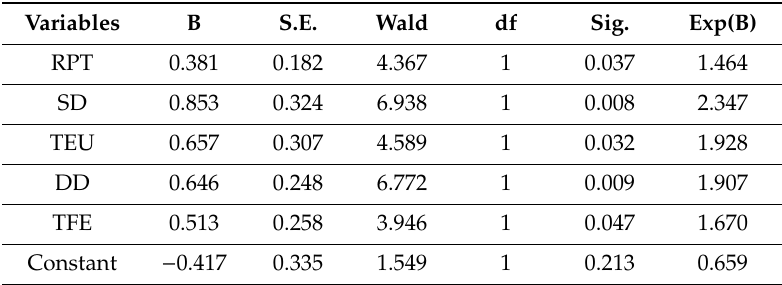
Table 3. Results of binary logistic regression